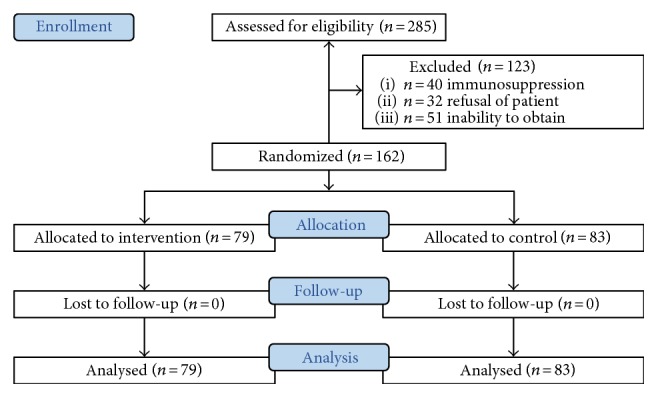
CONSORT diagram of included patients.